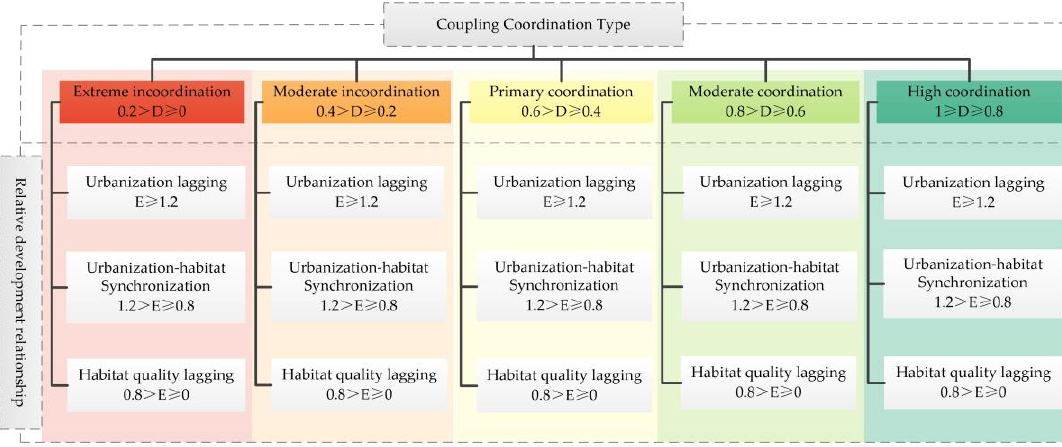
Figure 3. Coupling coordination types of urbanization and HQ.